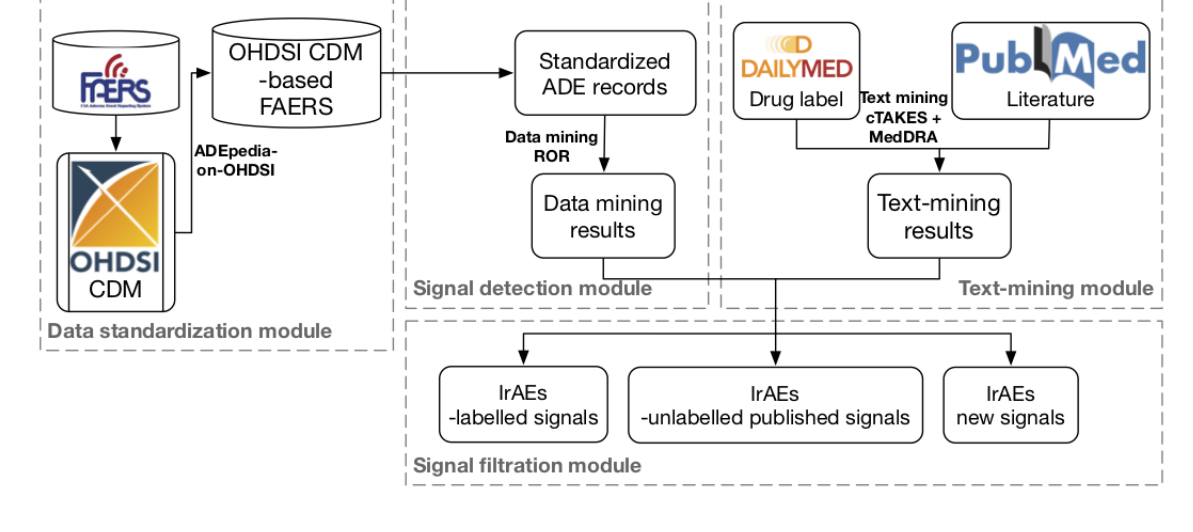
categories: standardized clinical data, standardized health system data, standardized health economics, standardized metadata, standardized vocabularies, and standardized derived elements.